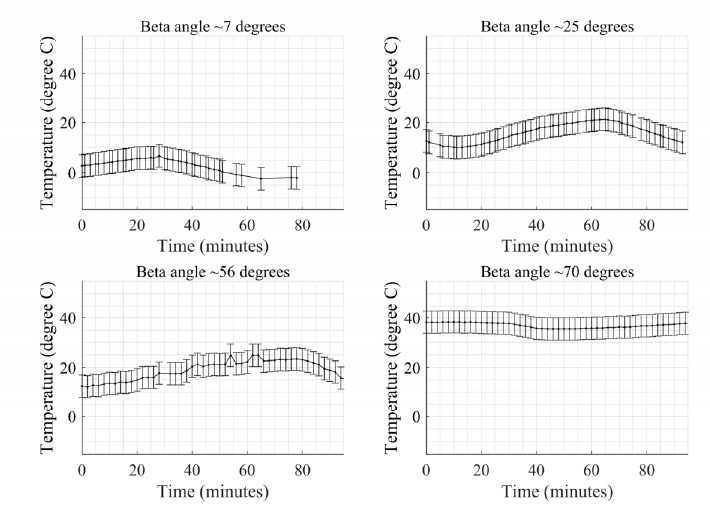
Figure 18. On ‐ orbit temperature variation of SIoT board with respect to the beta angle. Figure 18. On-orbit temperature variation of SIoT board with respect to the beta angle.